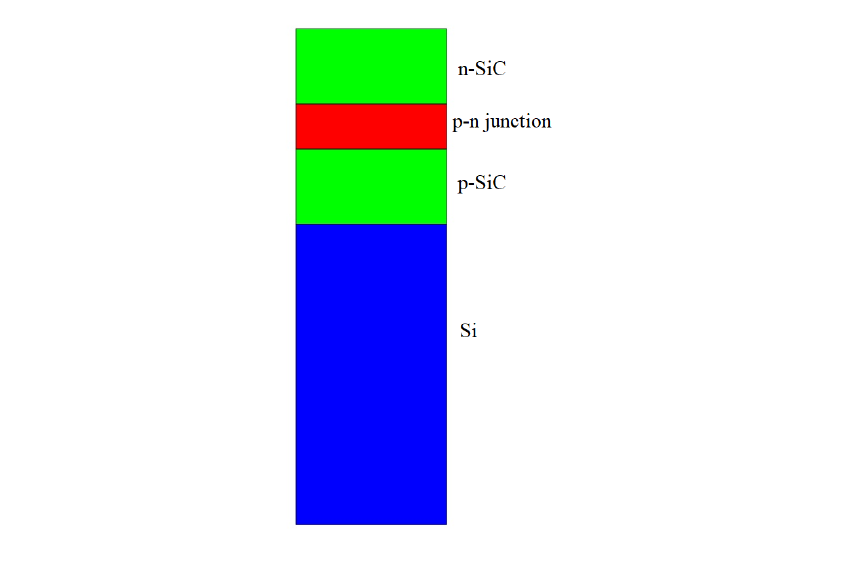
the thickness of the Space charge region area of the p – n junction (red) is 3 µ m. The p-SiC (green) layer is 5 µ m. The rest of the volume is occupied by a silicon substrate (blue). Simulation